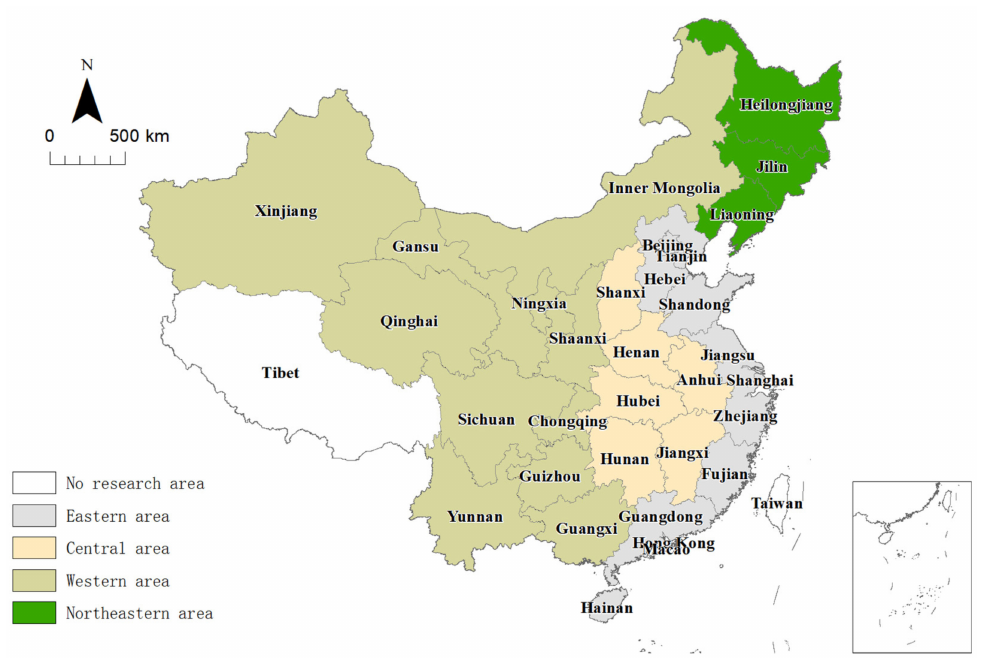
Figure 2. Diagram of China’s four regional economic zones. Data source: NBSC (2022)